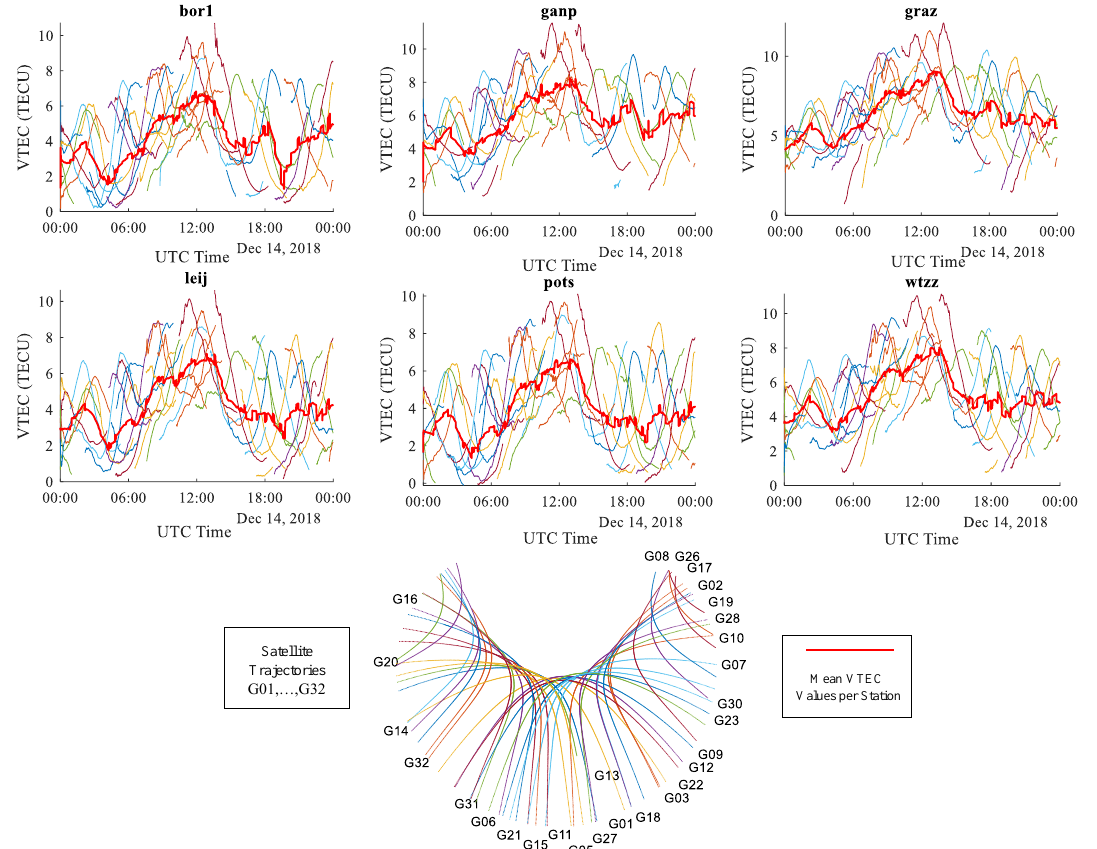
Figure 5. VTEC (TECU) predictions on 14 December 2019 for six stations (bor1, ganp, graz, leij, pots, wtzz) per satellite ID (G1,..., G32 for GPS satellite), and mean VTEC value (with red